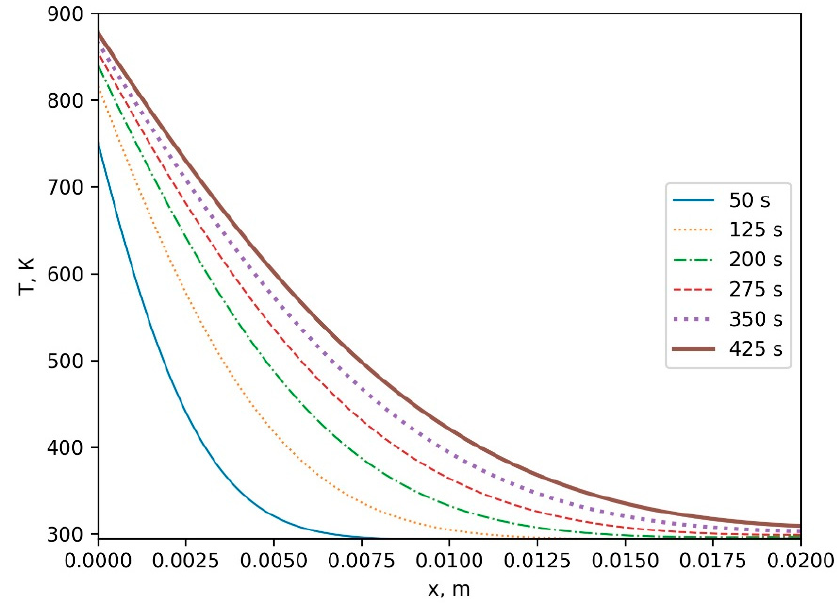
Figure 10. Impact of a surface forest fire (low intensity) on plywood from a distance of 20 m—temperature distribution along the wall thickness.